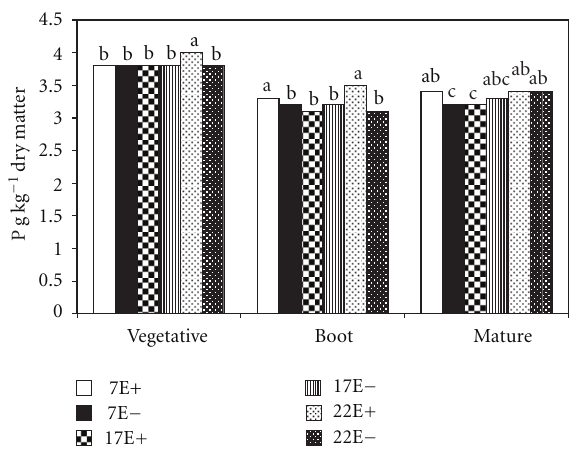
Figure 6: Plant × endophyte × maturity e ff ect on gkg − 1 dry matter P concentrations from the greenhouse. Within maturity, columns with di ff ering letters are significantly di ff erent at P = .